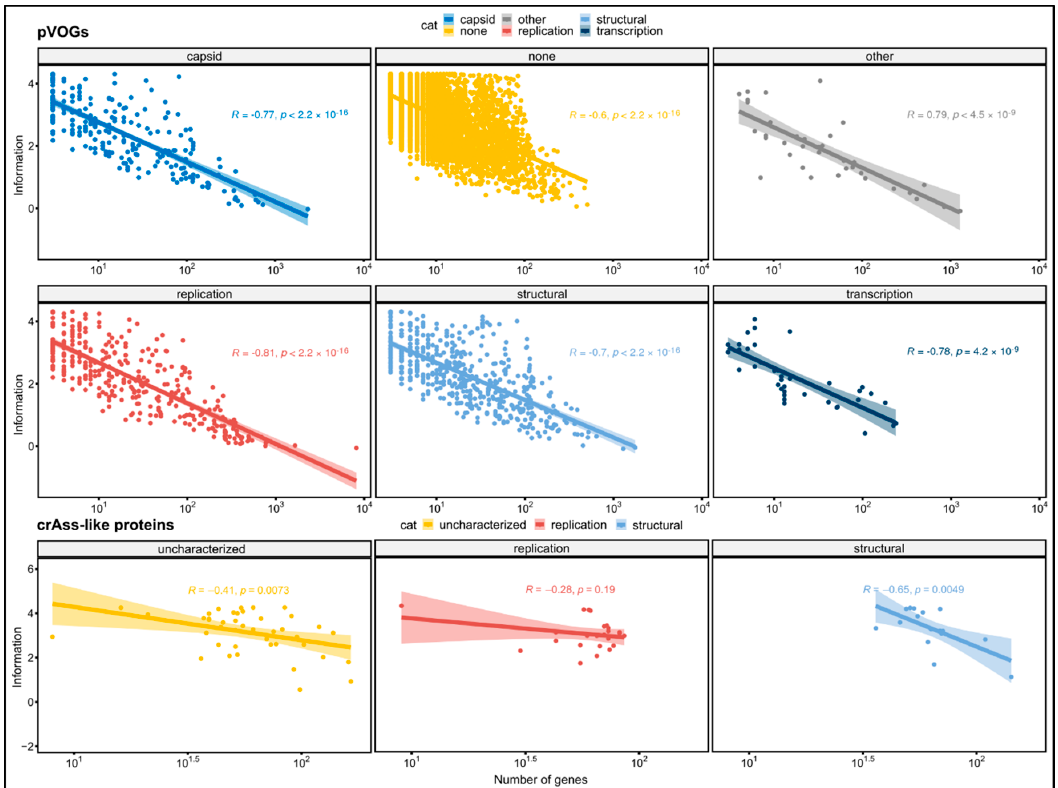
Figure 2. Correlation between the logarithm of the number of sequences in a protein family and the Shannon information content of the positions in the protein sequence alignment. Inverse correlations were obtained both for crAss-like viruses and pVOGs. For proteins in crAss-like viruses, only functional classes having more than four genes are reported.